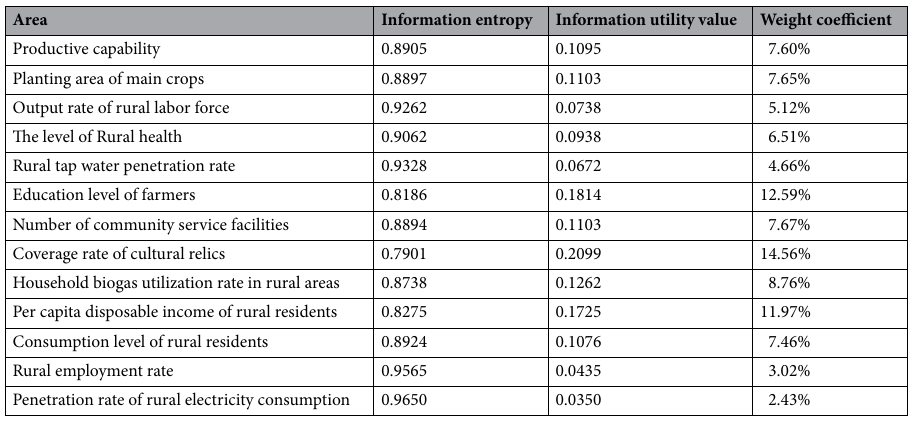
Table 2. The weight of the evaluation